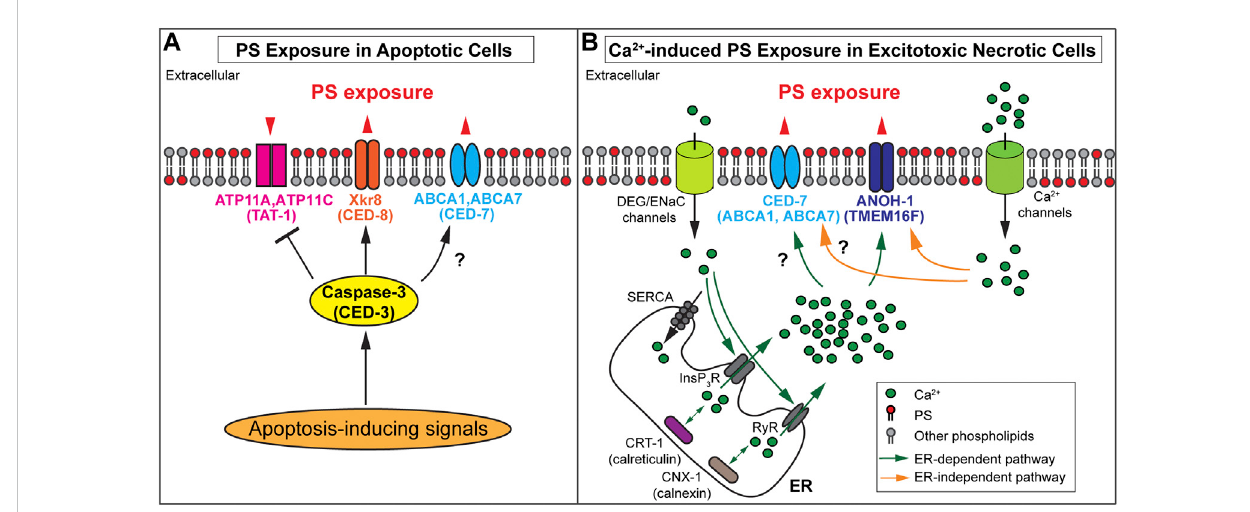
FIGURE 2 Mechanisms of PS exposure on apoptotic cells and necrotic cells (A) Protein names in paratheses are the Caenorhabditis elegans homologs of the mammalian proteins. In apoptotic cells, activated caspase-3 cleaves PS scramblases Xkr8 or CED-8 to trigger PS scrambling activity and cleaves the fl ippasesATP11A andATP11Ctoinactivate thePS fl ippingactivity.Itisunclearwhetherthe Caenorhabditis elegans homologTAT-1 isinactivatedbyCED- 3. Furthermore, ABCA1 and CED-7 are necessary for PS exposure on apoptotic cells. The black question mark indicates whether the caspase regulates these transporters remains elusive. (B) Protein names in paratheses are the mammalian homologs of the Caenorhabditis elegans proteins. In excitotoxic necrotic cells, Ca 2+ in fl ux through various ion channels elevates cytoplasmic Ca 2+ levels in ER-dependent or ER-independent